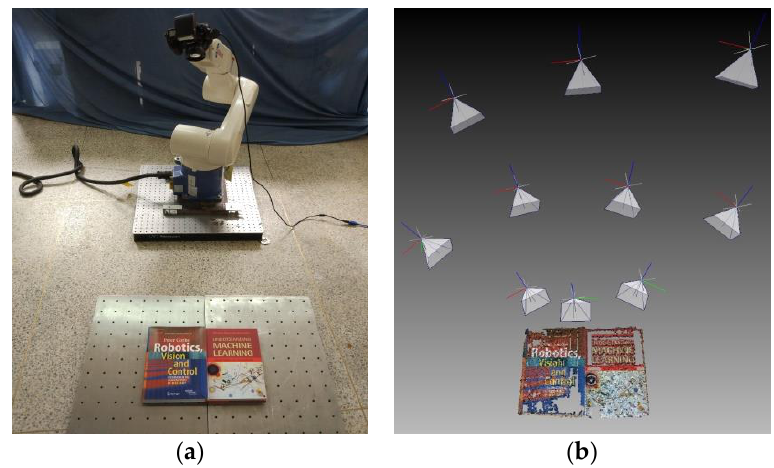
Figure 4. Sample images of calibration scenarios taken by the camera mounted on the gripper of the robot: ( a ) Chessboard pattern scene; ( b ) Books scene.